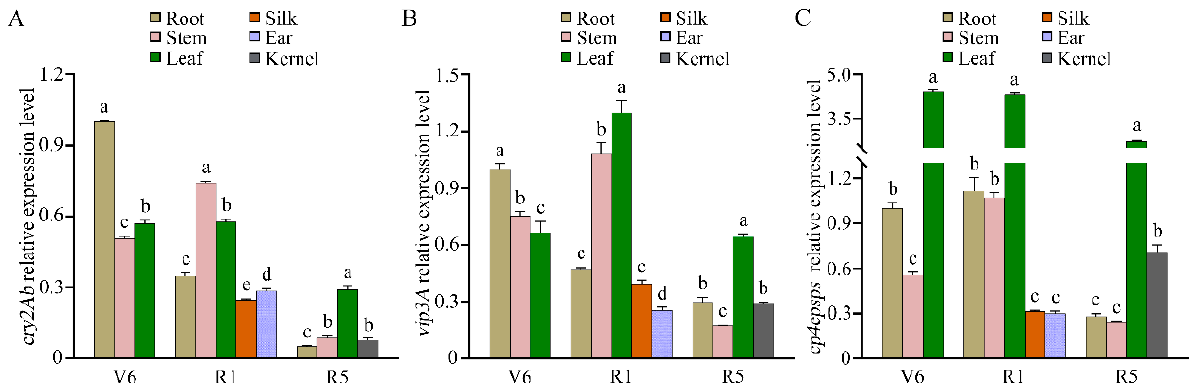
Figure 5. Relative expression levels of cry2Ab ( A ), vip3A ( B ), and cp4epsps ( C ) in the transgenic maize CVC-1. The data in all the samples are expressed as means ± standard deviation ( n = 3). Different lowercase letters indicate significant differences among the plant tissues at the same developmental stages with Duncan’s multiple range test (one-way ANOVA; p < 0.05). V6: the six-leaf stage, R1: